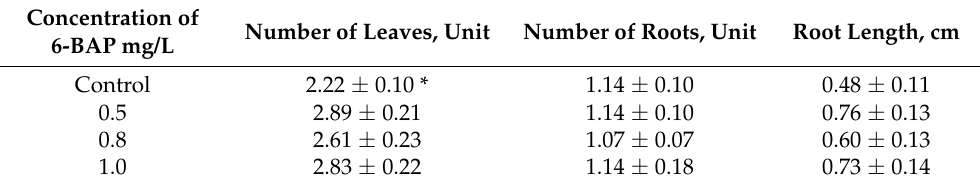
Figure 3. Influence of different concentrations of 6-BAP on the number of newly formed protosomes after 60 days of cultivation (LSD 05 0.68). Table 1. Influence of 6-BAP concentration on the morphometric parameters of C. erythrostylum protosomes after 60 days of